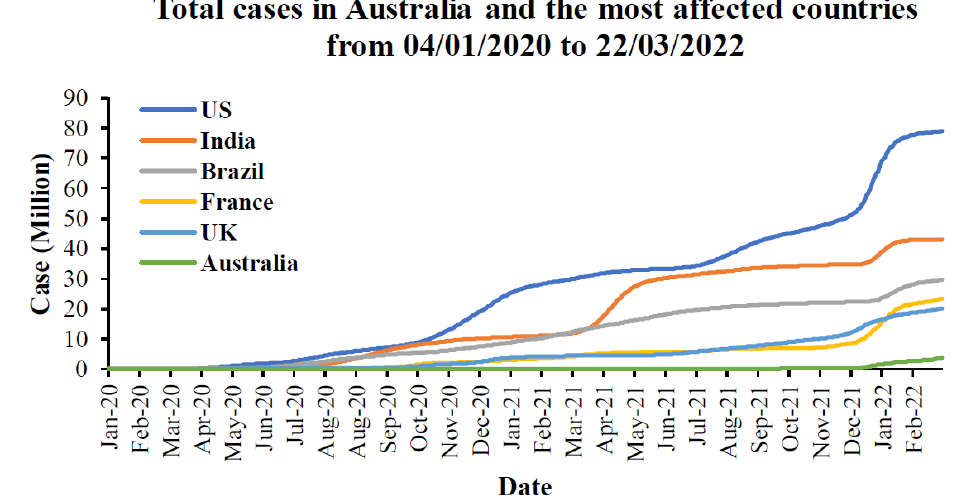
Figure 3. Total cases in Australia and the most affected countries from 4 January 2020 to 22 March 2022 [64].